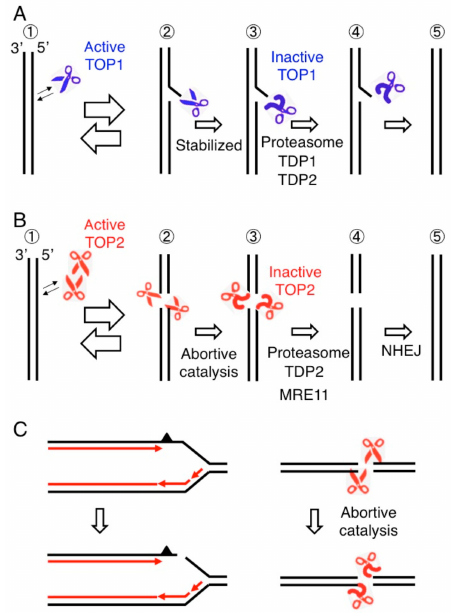
Figure 2. Abortive catalysis of topoisomerases causes DNA cleavage. ( A ) TOP1 cleaves one strand of a DNA double helix and religates the nick (Step 1 and 2). Topoisomerase I (TOP1) is covalently associated with 3 (cid:48) end generating a TOP1 cleavage complex (TOP1cc shown in Step 2). TOP1 occasionally fails